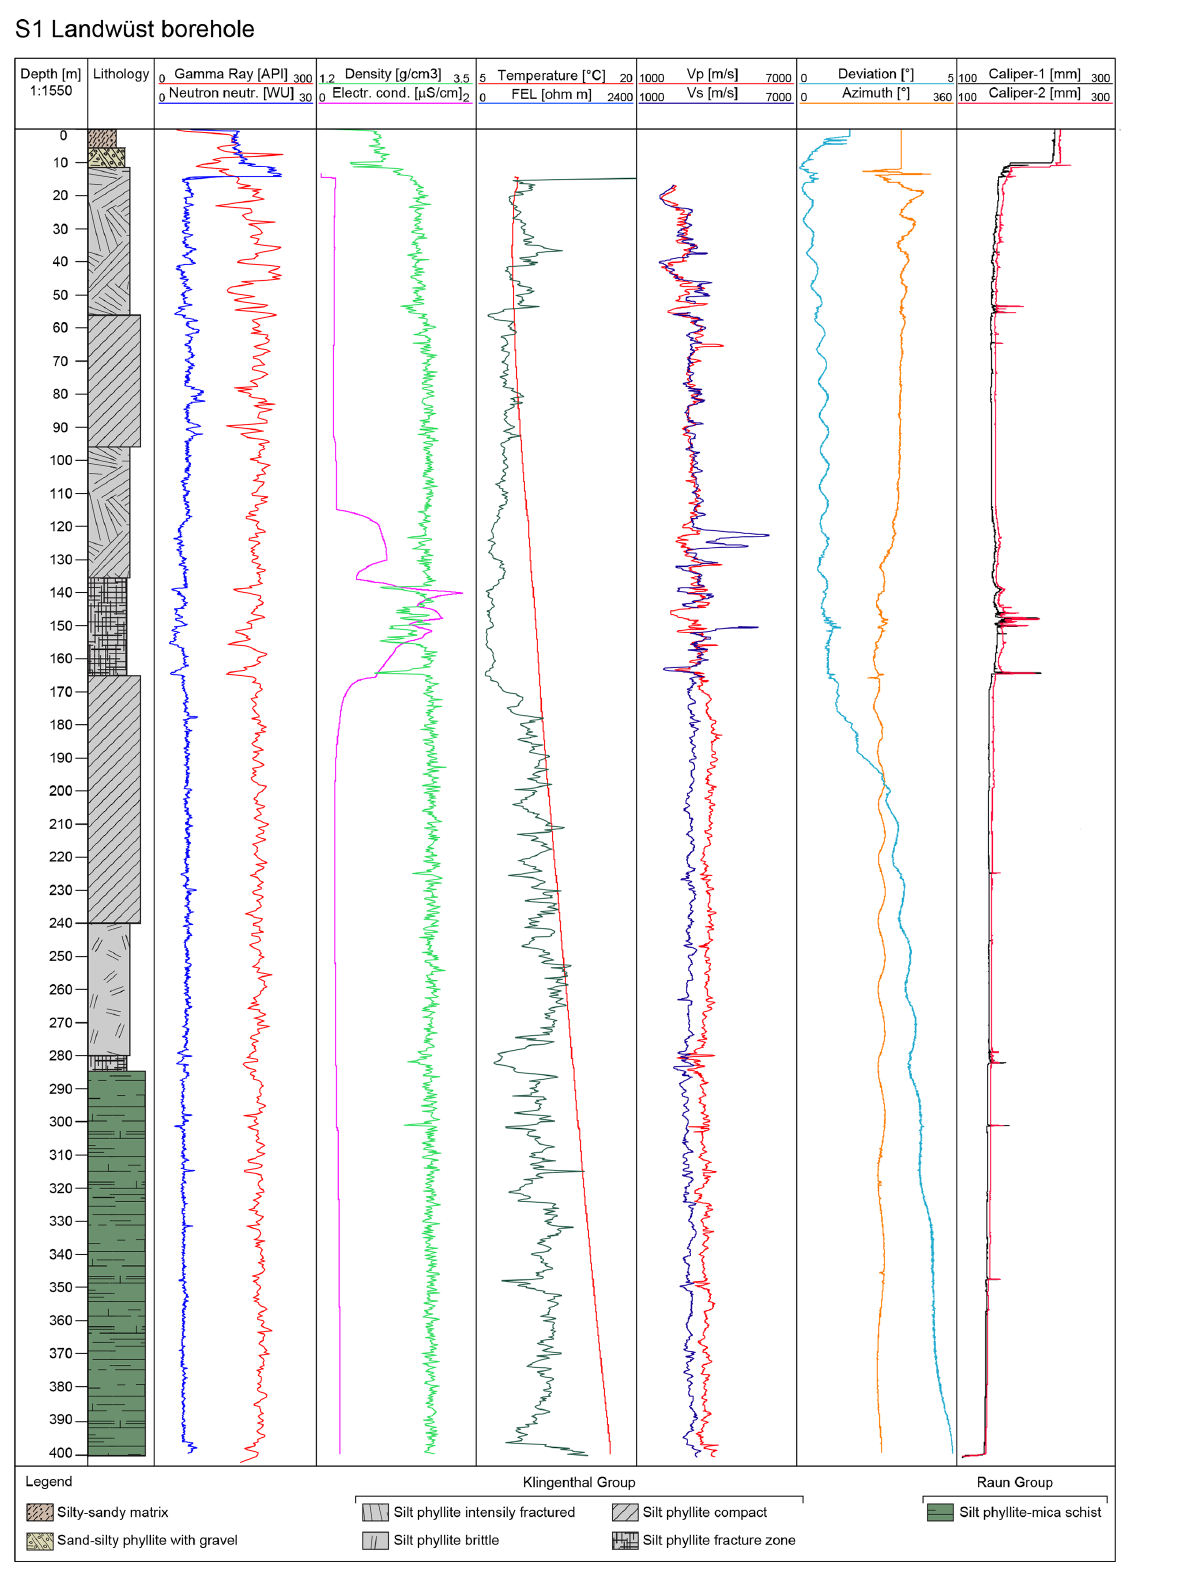
Figure 8. Logging data of the S1 Landwüst borehole and a stratigraphy profile based on the initial core description. The abbreviations used in the figure are as follows: Neutron neutr. – neutron–neutron; WU – water unit; Electr. cond. – electrical conductivity; FEL – focus electrical resistivity; V p and V s – P- and S-wave velocity,